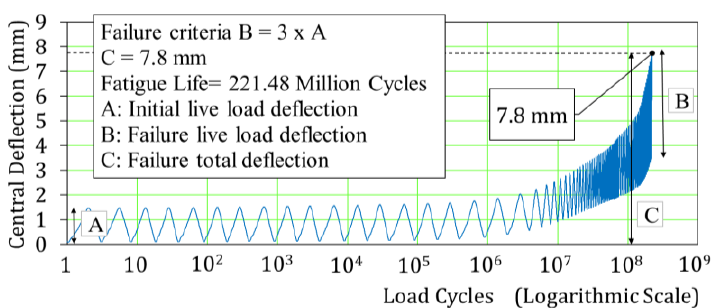
Figure 4. Cyclic passage of moving wheel type load versus live-load deflection at span center for the referential RC deck.